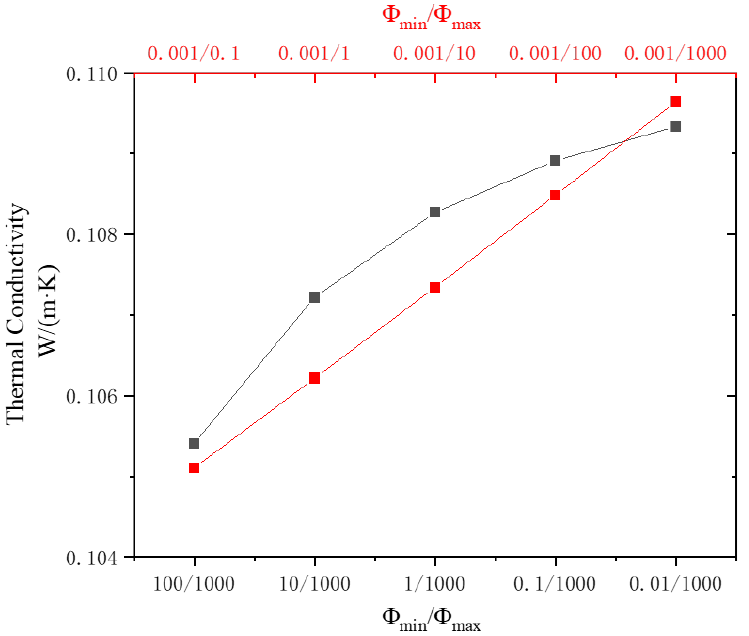
Figure 14. The influence of the pore diameter distribution on the ETC.